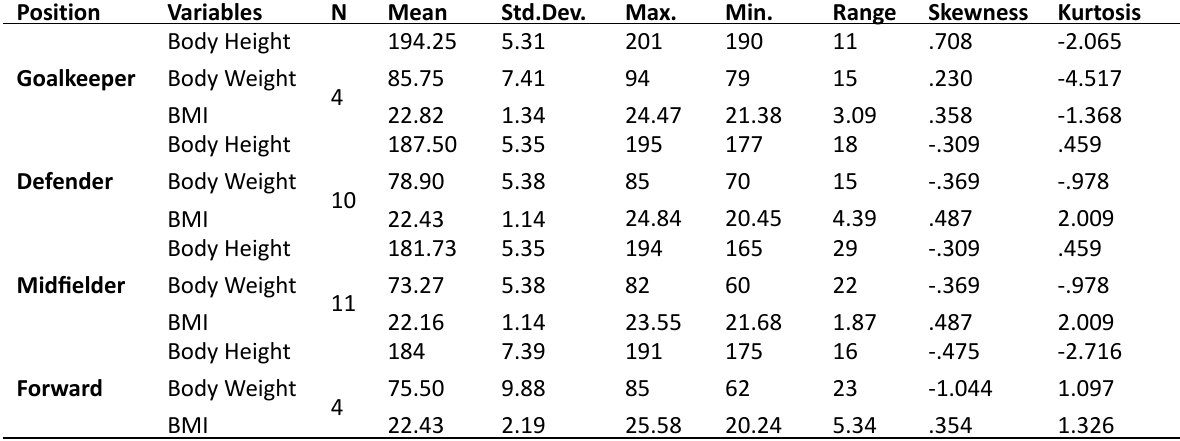
Table 1. Descriptive parameters of the football player in relation to the player’s position